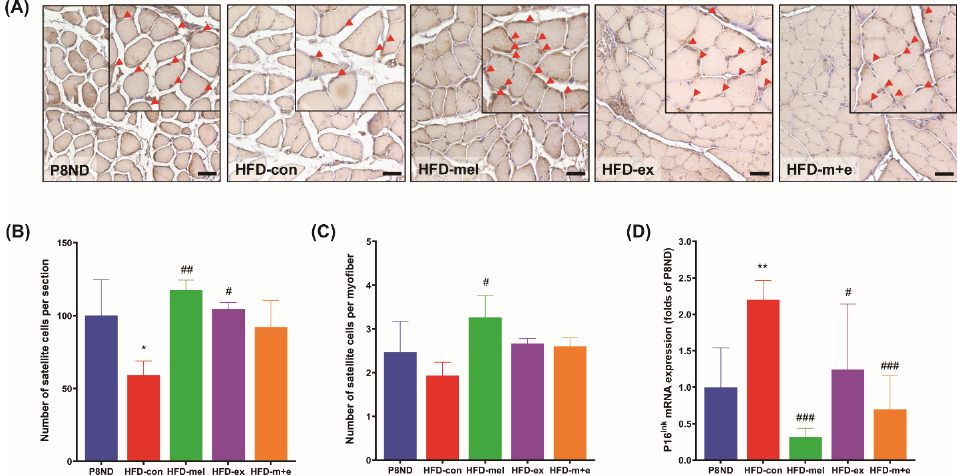
Figure 4. Melatonin and exercise training protected against obesity-induced deterioration of satellite cells’ population and senescence: ( A ) Representative Pax7-positive SC numbers (brown) in each group. Scale bar = 25 μ m at 40× magnification; arrowheads indicate SCs. Bar graphs illustrating ( B ) the number of SCs per section (n = 3 mice per group), ( C ) the number of SCs per myofiber (n = 3 mice per group), and ( D ) the relative mRNA expression of p16 ink (n = 6 mice per group). Data are the mean ± SD; * p < 0.05 and ** p < 0.05 vs. P8ND; # p < 0.05, ## p < 0.01, and ### p < 0.001 vs. HFD-con using unpaired t -tests.